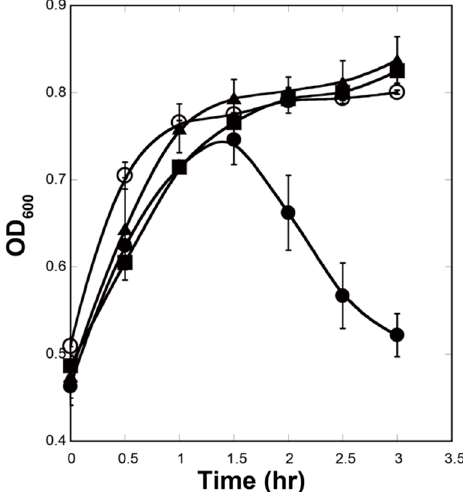
Figure 10. Full-length gp5 is translocated into the periplasmic space during overexpression. The cell turbidity assay of E. coli expressing gp5 (filled circles), T4L (filled triangle) and carrying a pET29a empty vector (filled squares). The cells were induced at T = 0 with 1 mM IPTG. Purified gp5 was added to E. coli cell culture harboring a pET29a vector (empty circles) at T = 0. The cell turbidity was measured at a wavelength of 600 nm. The symbols correspond to the averages and the bars to the standard deviations of n = 3 experiments.